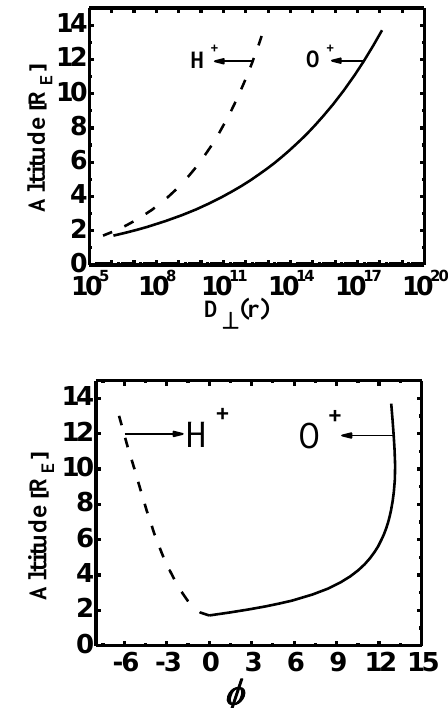
Fig. 1. Altitude profiles of ions potential energy (φ) due to the grav- Fig. 1: itational force and polarization electrostatic field, for O + ions (solid line) and H + ions (dashed line), when perpendicular wavelength of the electromagnetic turbulence λ ⊥ =